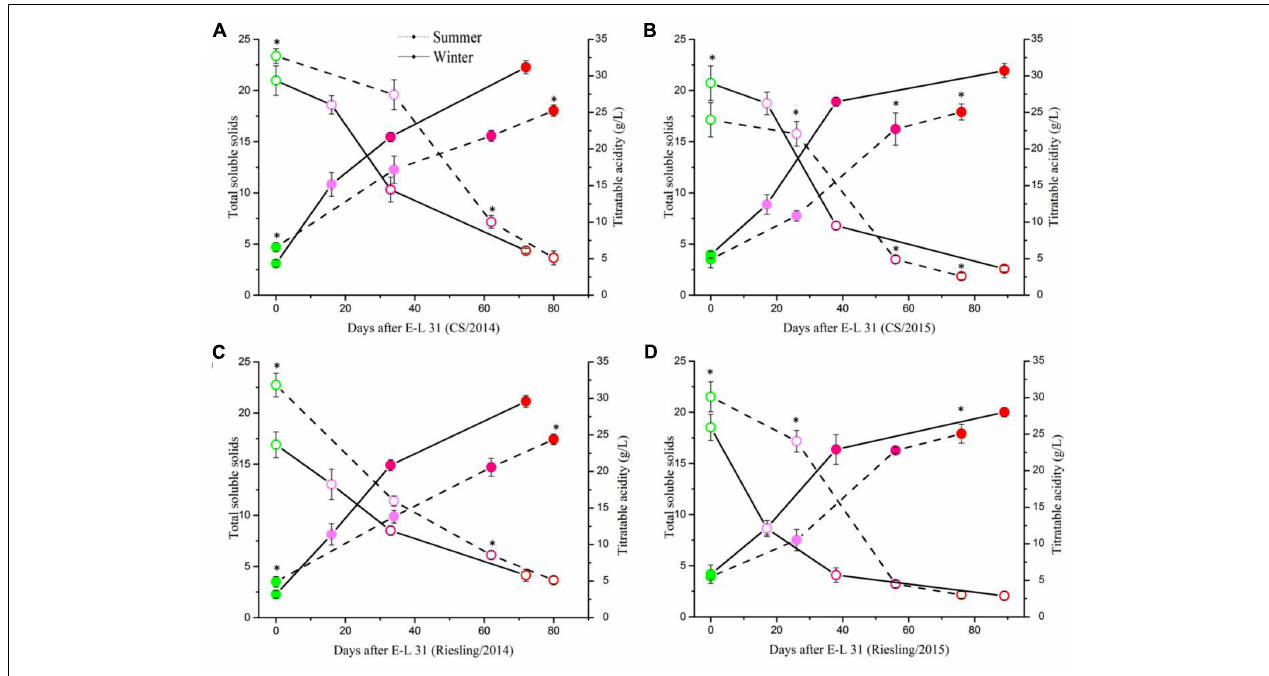
FIGURE 3 | Evolution of total soluble solids and titratable acidity in ‘Cabernet Sauvignon’ (A,B) and ‘Riesling’ (C,D) grapes grown under double cropping system in 2014 (A,C) and 2015 (B,D) . The four points from green to red referred to stage of E-L 31/35/36/38, respectively. The asterisk indicates significant differences between the samples from the same